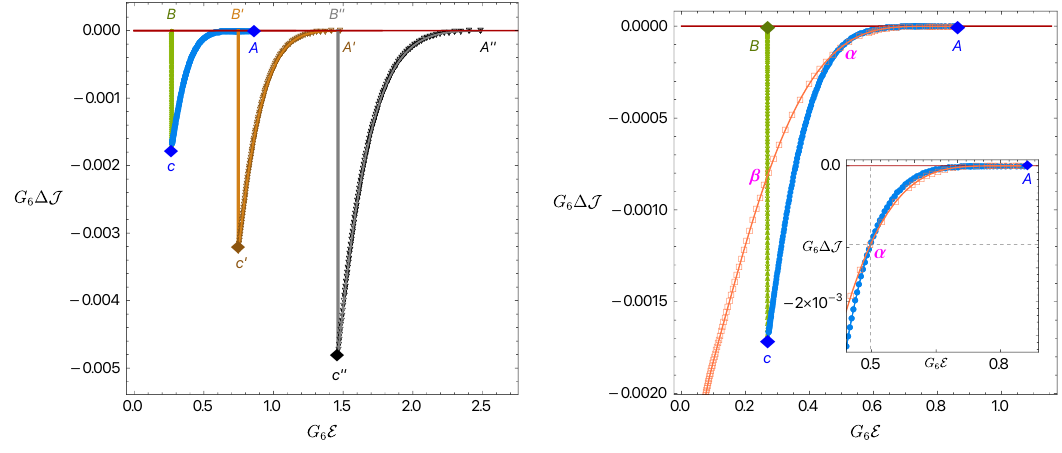
Figure 9 . Onset/cutoff curves for the m = 2 , 3 , 4 superradiant instability and the zero mode curve of Gregory-Laflamme instability (orange squares on right panel). The vertical axis describes the difference between a given solution and the extremal Myers-Perry solution that has the same energy, ∆ J ≡ ( J − J ext ) | . Equally-spinning Myers-Perry black strings are unstable to m = 2 , m = 3 same E and m = 4 superradiant perturbations if they lie inside the regions ABc , A 0 B 0 c 0 and A 00 B 00 c 00 , respectively. They are unstable to the m = 0 Gregory-Laflamme instability if they are contained above the orange square curve (and below the horizontal extremal curve with ∆ J = 0 ) in the right panel. All the points in this figure are in a 1-to-1 correspondence to the same points in figure